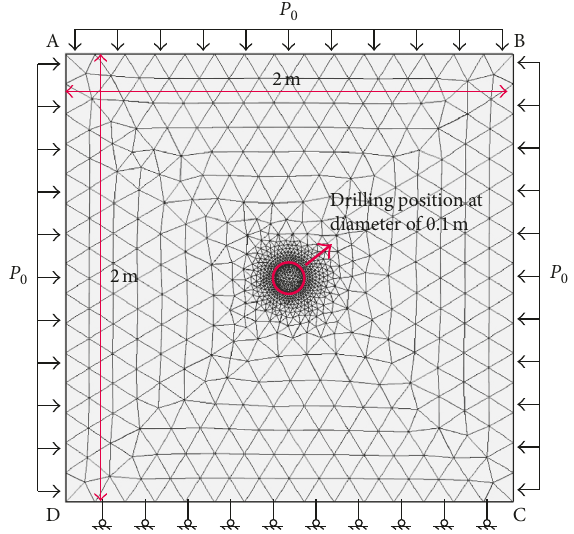
Figure 9: Physical model and boundary conditions.